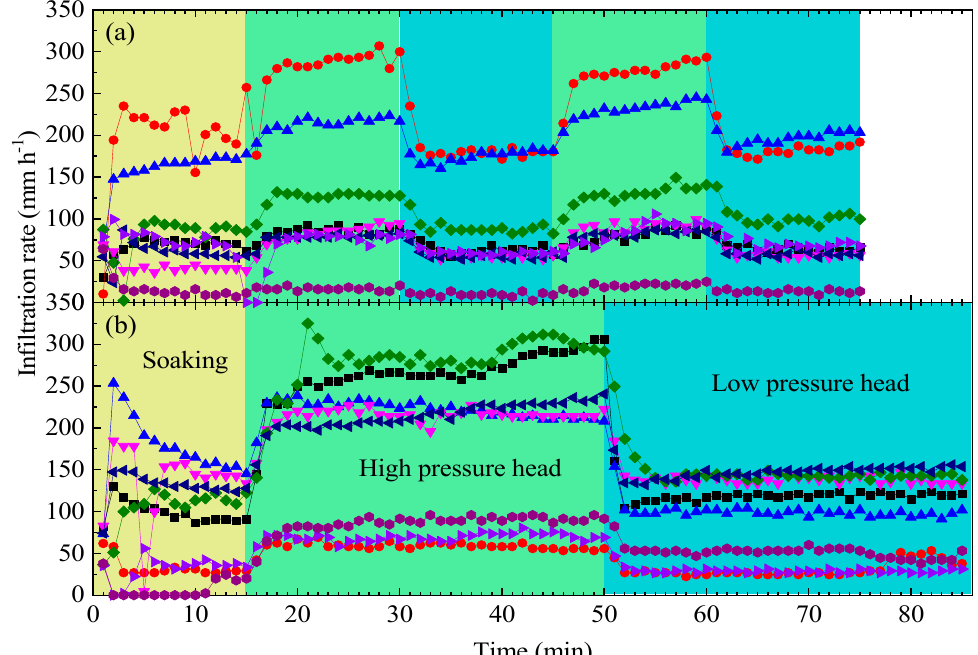
Figure 4. Infiltration rates of experiments conducted in winter months with ( a ) the default settings and ( b ) the optimized measurement parameters, as given in Table 2.